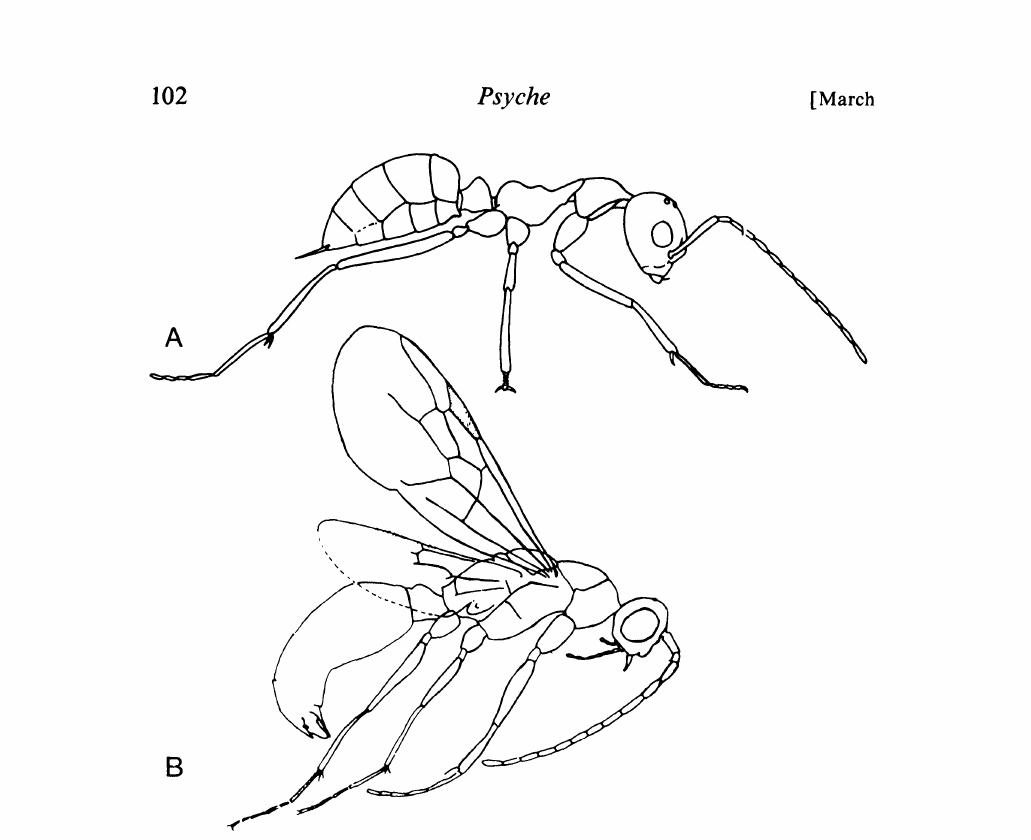
Figure 3A. Sphecomyrmafreyi Wilson and Brown from the lower part of Upper Cretaceous of New Jersey. Drawing of holotype worker in Museum of Comparative Zoology, modified from Wilson, Carpenter, and Brown (1967). Length of body, 3.5 mm. Figure 3B. Paleomyrmex zherichini Rasnitsyn from the lower part of the Upper Cretaceous of U.S.S.R. Drawing of holotype male in Paleontological Institute, Moscow, from Rasnitsyn, 1977. Length of body, 5.4